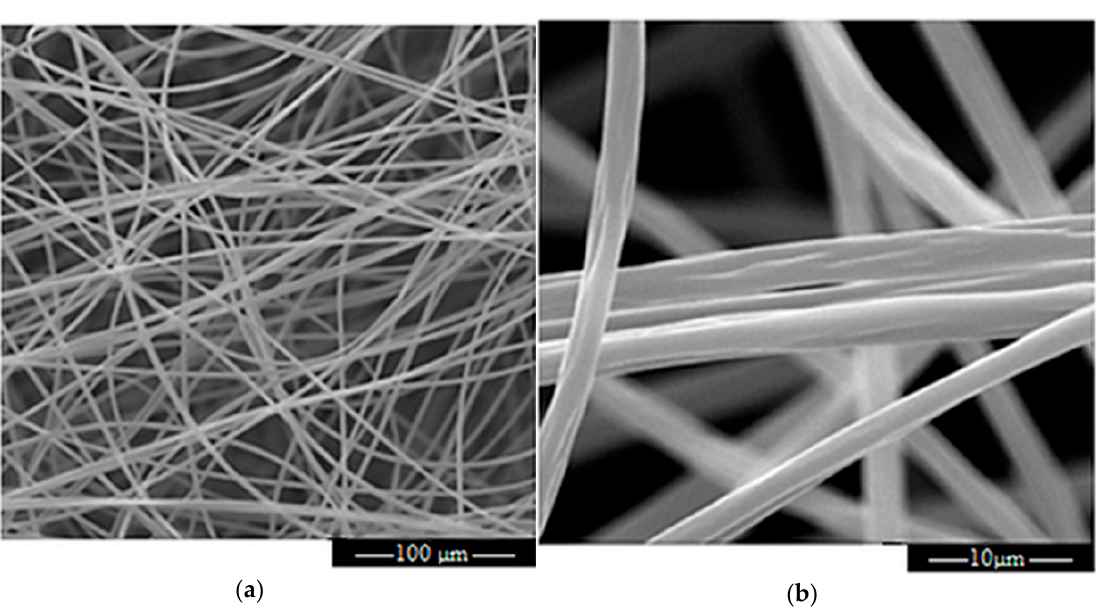
Figure 6. ( a ) SEM micrograph of PVP-G1.92; ( b ) SEM micrograph of PVP-G1.92 at an higher magnification.